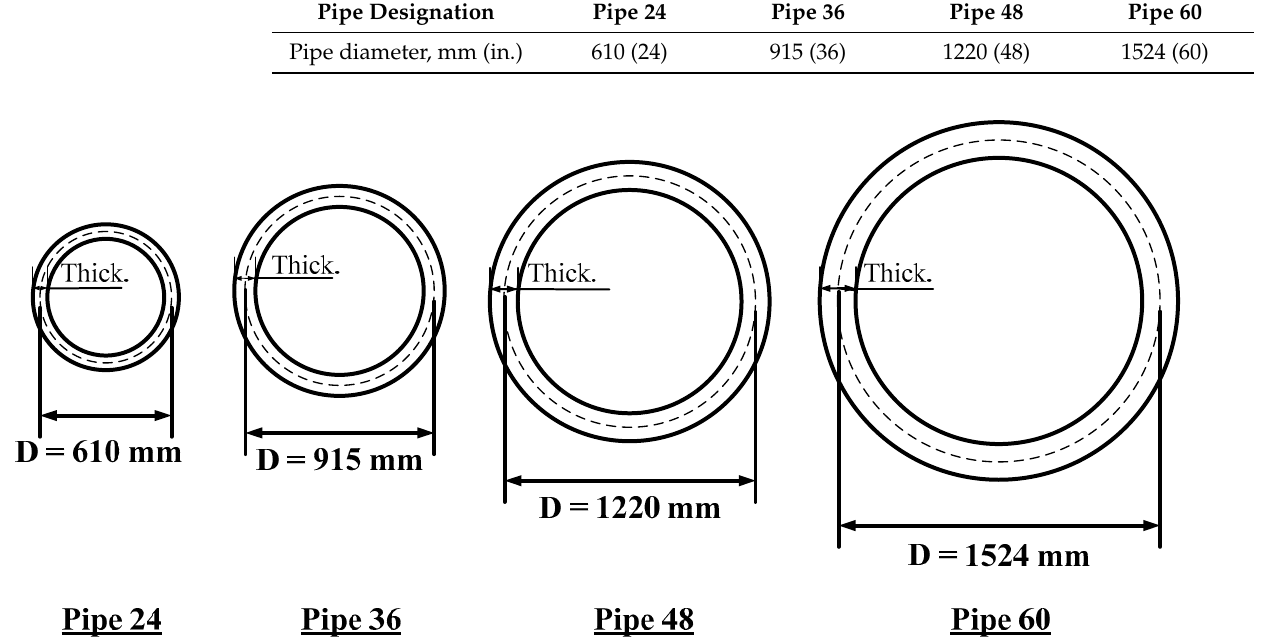
Figure 1. Geometric dimensions of the investigated pipeline culverts in this study.